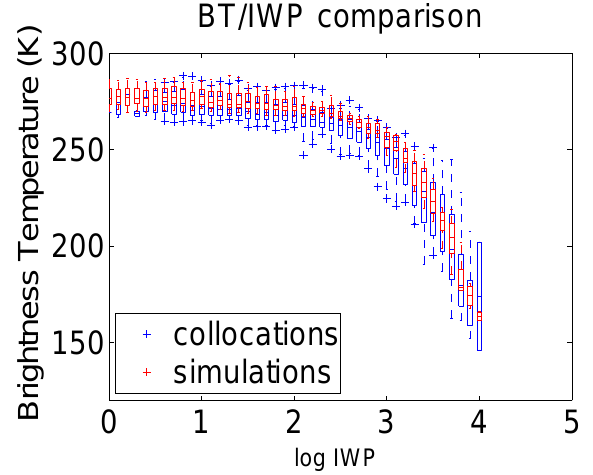
Fig. 8. Modified boxplot of Ice Water Path and MHS channel 5 or AMSU-B channel 20 brightness temperature. Radiances are binned in 10 log IWP bins with a width of 0.1 log g/m 2 . In each bin, the median brightness temperature is shown as a horizontal line. The upper and lower bars of the rectangle show the 1st and 3rd quartile (25th and 75th percentile). From the rectangles, dashed lines con- nect to the 1st and 99th percentile. All other points are defined as outliers and plotted as pluses. Collocations are shown in blue and simulations are shown in red.